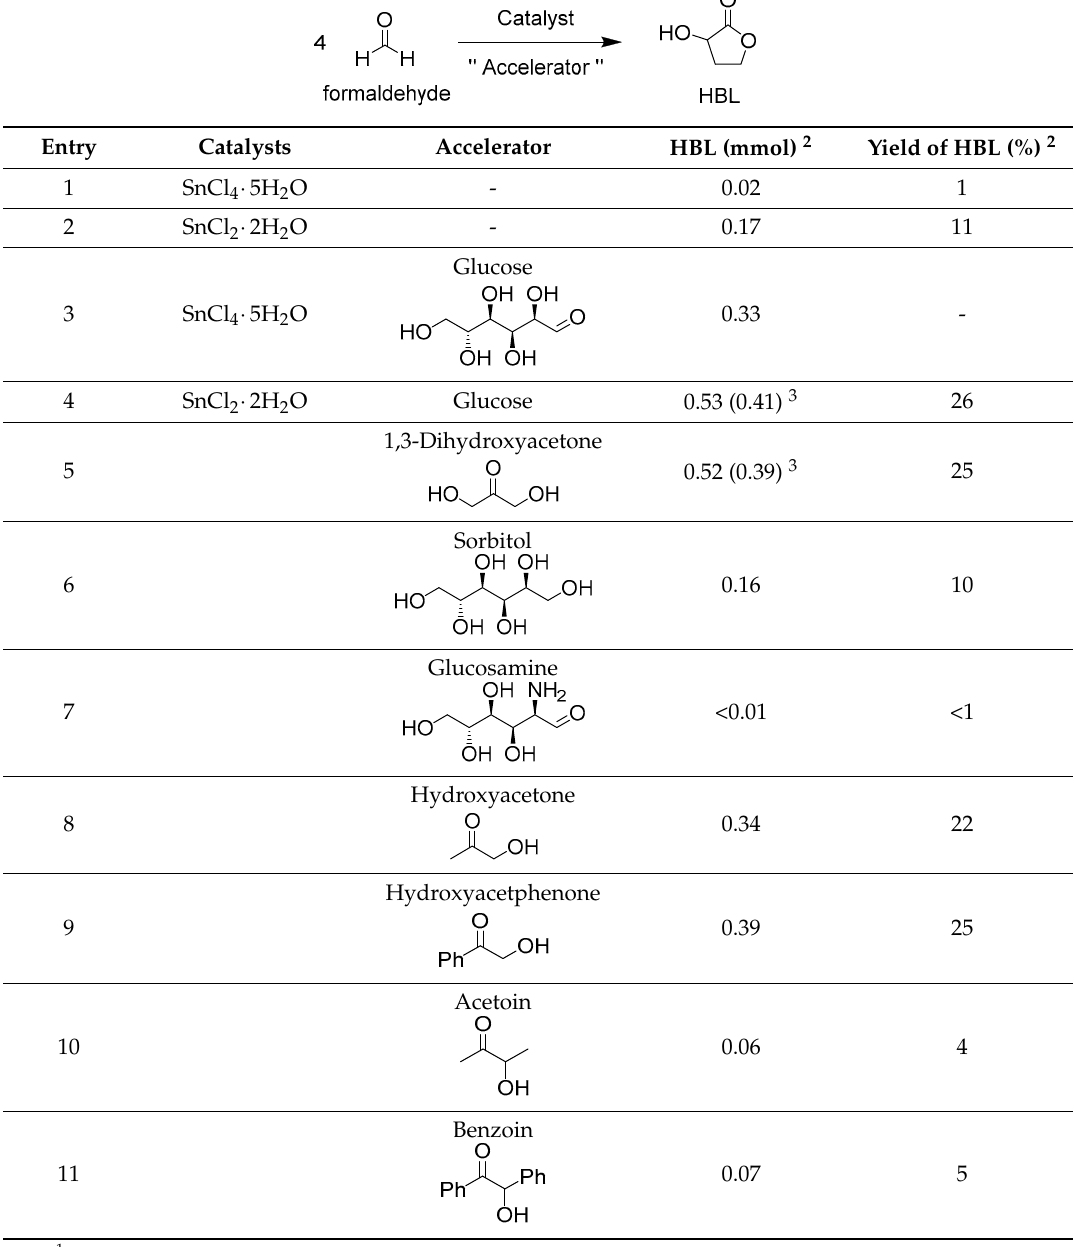
Table 4. Screening of accelerators bearing an α -hydroxy carbonyl moiety 1 .